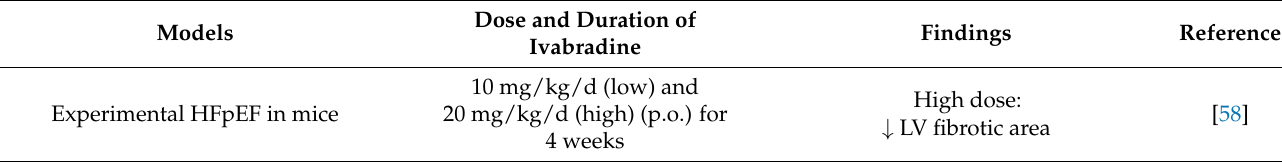
Table 5. Effects of ivabradine on interstitial fibrosis in experimental heart